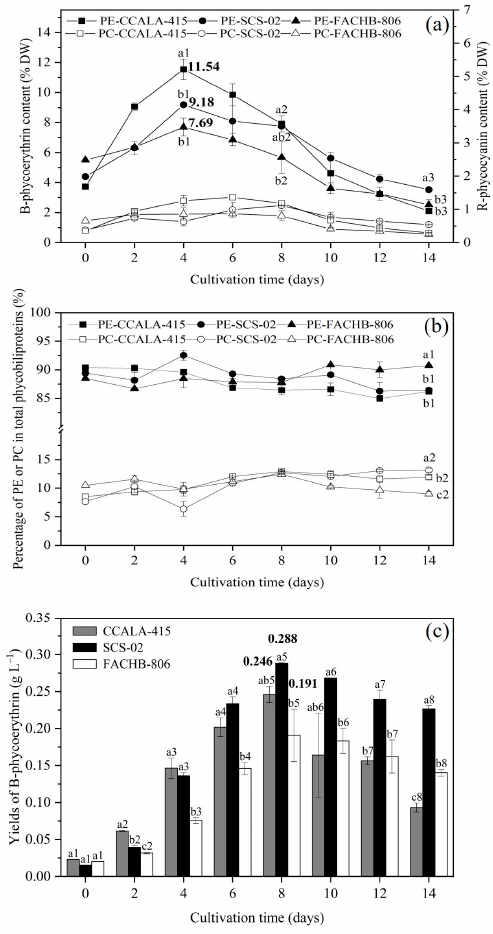
Figure 3. Accumulation characteristics of phycoerythrin and phycocyanin in Porphyridium cruentum CCALA-415, Porphyridium purpureum SCS-02 and Porphyridium purpureum FACHB-806. ( a ) The changes of B-phycoerythrin and R-phycocyanin content as a function of time; ( b ) The percentage of phycoerythrin and phycocyanin in total phycobiliproteins; ( c ) The yields of B-phycoerythrin as a function of time. PE: phycoerythrin; PC: phycocyanin. The values shown are the averages of two biological replicates and three technical replicates ± standard deviation. Different letters in Figure 3a denote significant differences among the B-phycoerythrin content in the three strains of Porphyridium at the same cultivation time (a1–c1: day 4; a2–c2: day 8; a3–c3: day 14). Different